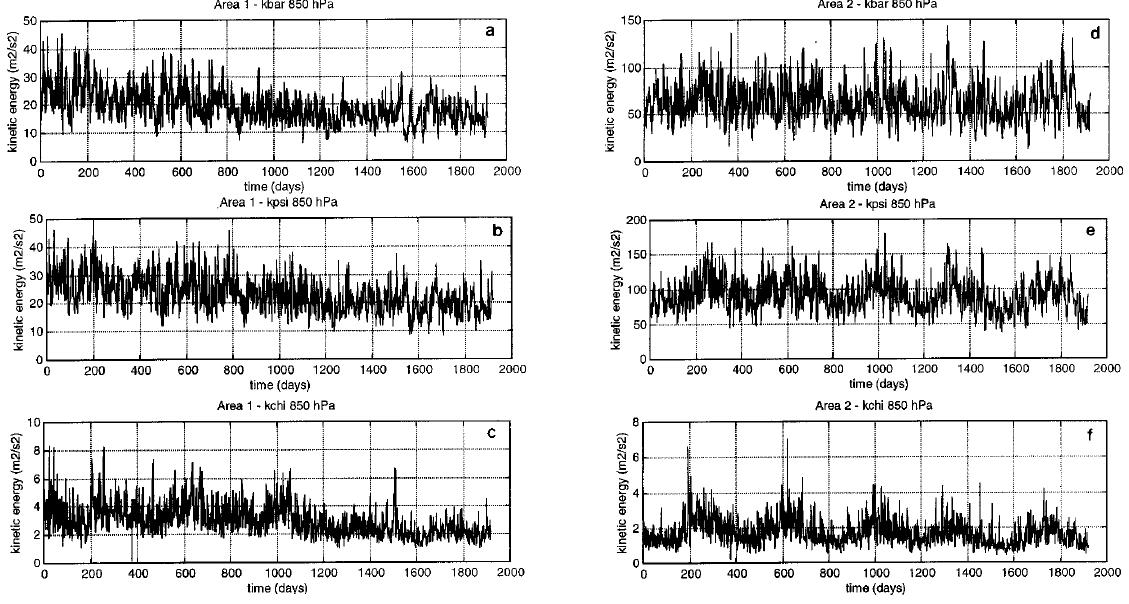
Fig. 1. Temporal variations of the kinetic energy (m 2 s − 2 ) at 850 hPa, mean for tropical South America: ( a ) K , ( b ) K ψ , ( c ) K χ , and extratropical South America: ( d ) K , ( e ) K ψ and ( f ) K χ . Zero represents 1 November 1985.